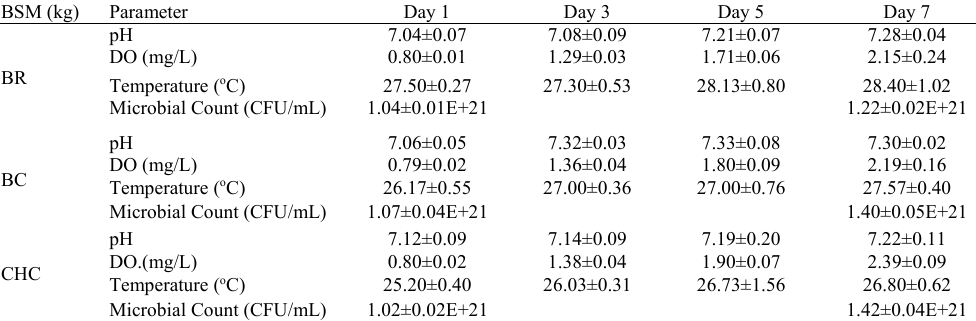
Table 5: Results for monitored parameters (pH, DO, Temperature, Microbial count)